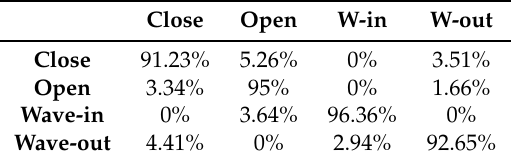
Table 3. Confusion matrix for the support vector machine (SVM) classifier: Training (accuracy: